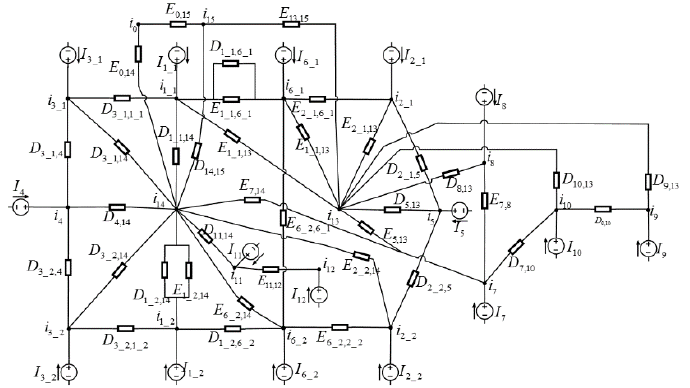
Figure 19. Equivalent thermal network model of the MLRW.